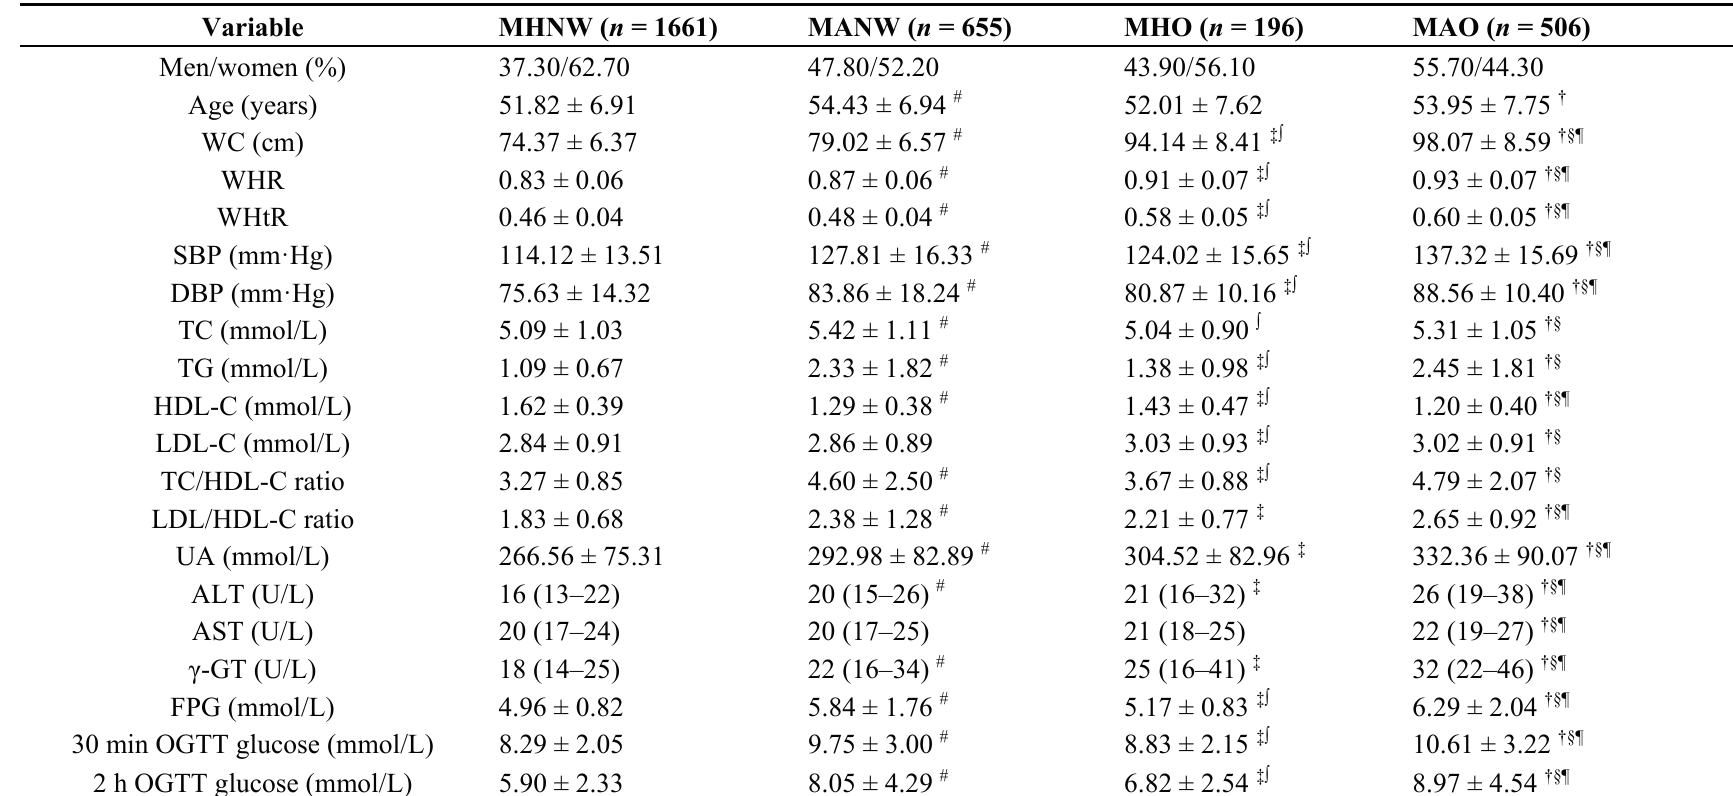
Table 1. The demographic and metabolic characteristics in the subjects of metabolically healthy normal weight (MHNW), metabolically abnormal normal weight (MANW), metabolically healthy obese (MHO) and metabolically abnormal obese